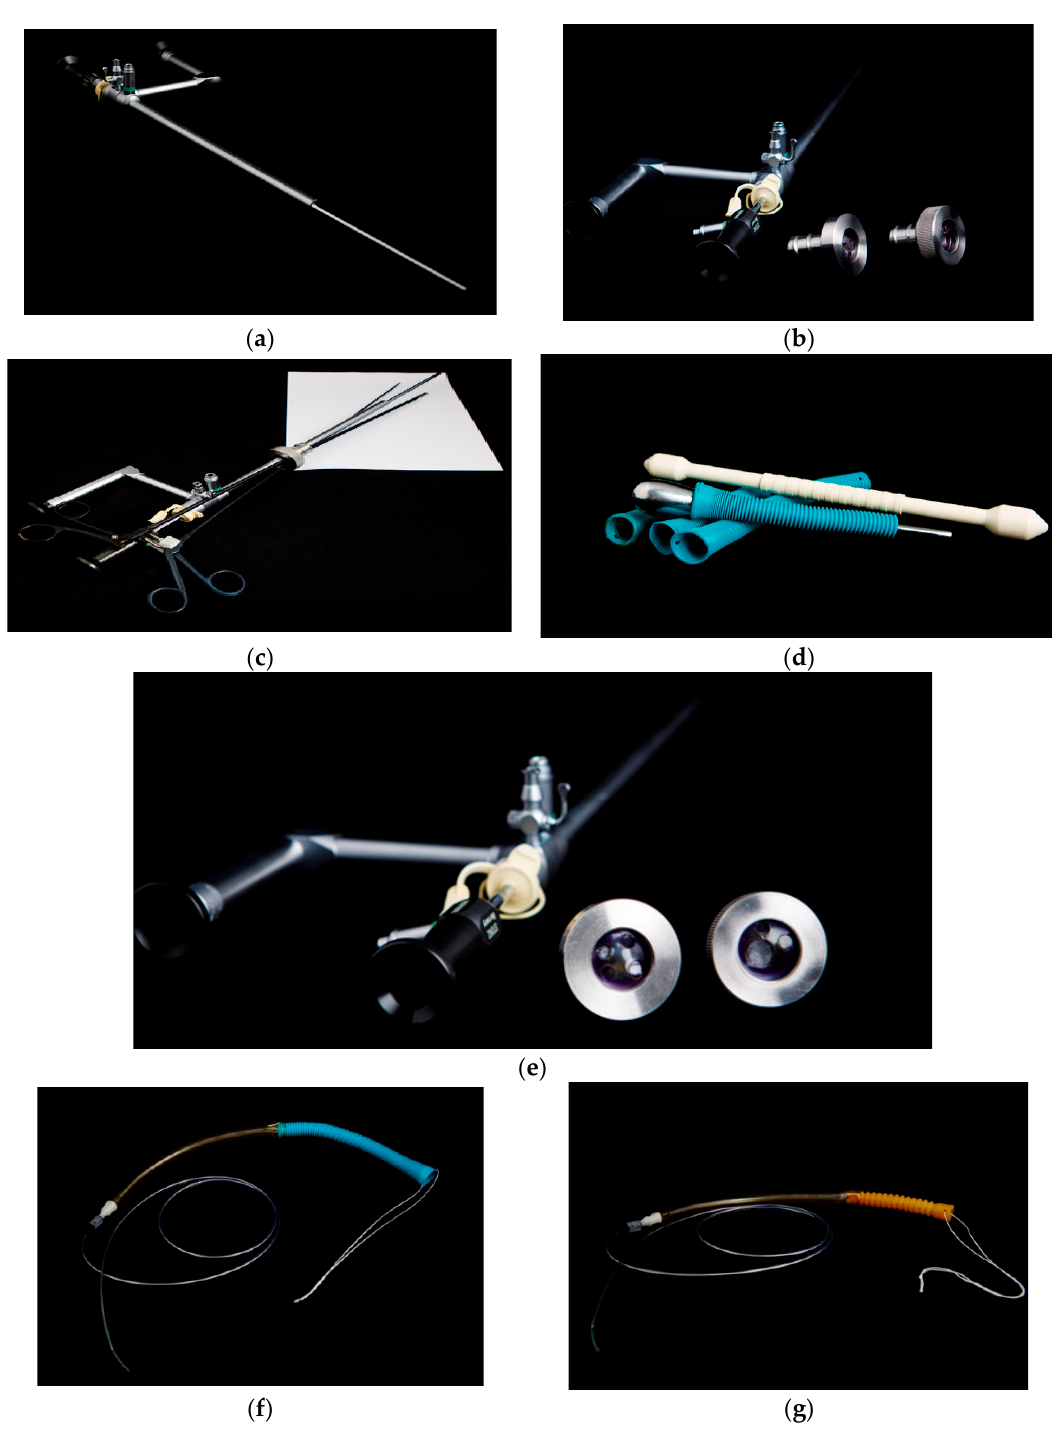
Figure 2. ( a ) Telescope with working channel. ( b ) Telescope with working channel with probe for retrograde catheterization (single-port system). ( c ) Auxiliary surgical instruments with single-port system. ( d ) Instruments used for the thermoregulation of stents. ( e ) Single-port system with 2 and 3 holes. ( f ) Anchoring assembly: tent-anchored oral fixation wire, stent, and intermediate segment crossed by endoluminal wire anchored by stent (upper pole) and lower-pole catheter. ( g ) Traction: complex proximal tension wire system, stent, intermediate tube and distal traction wire, and traction catheter.